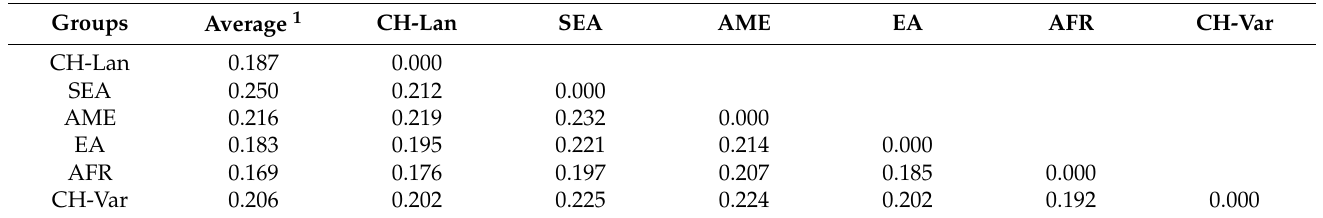
Table 3. Genetic distance (Nei&Li (Czekanowski(1913)) of 240 accessions within six groups based on InDel